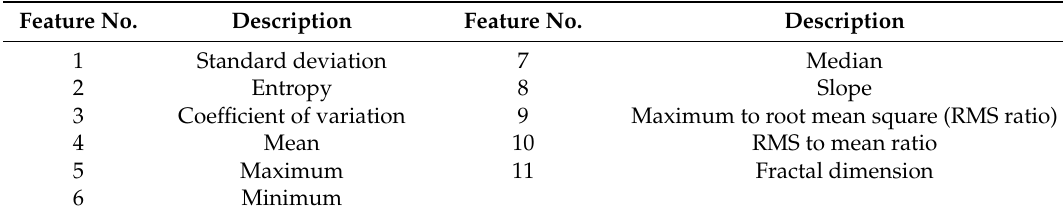
Table 3. Features extracted from sensor